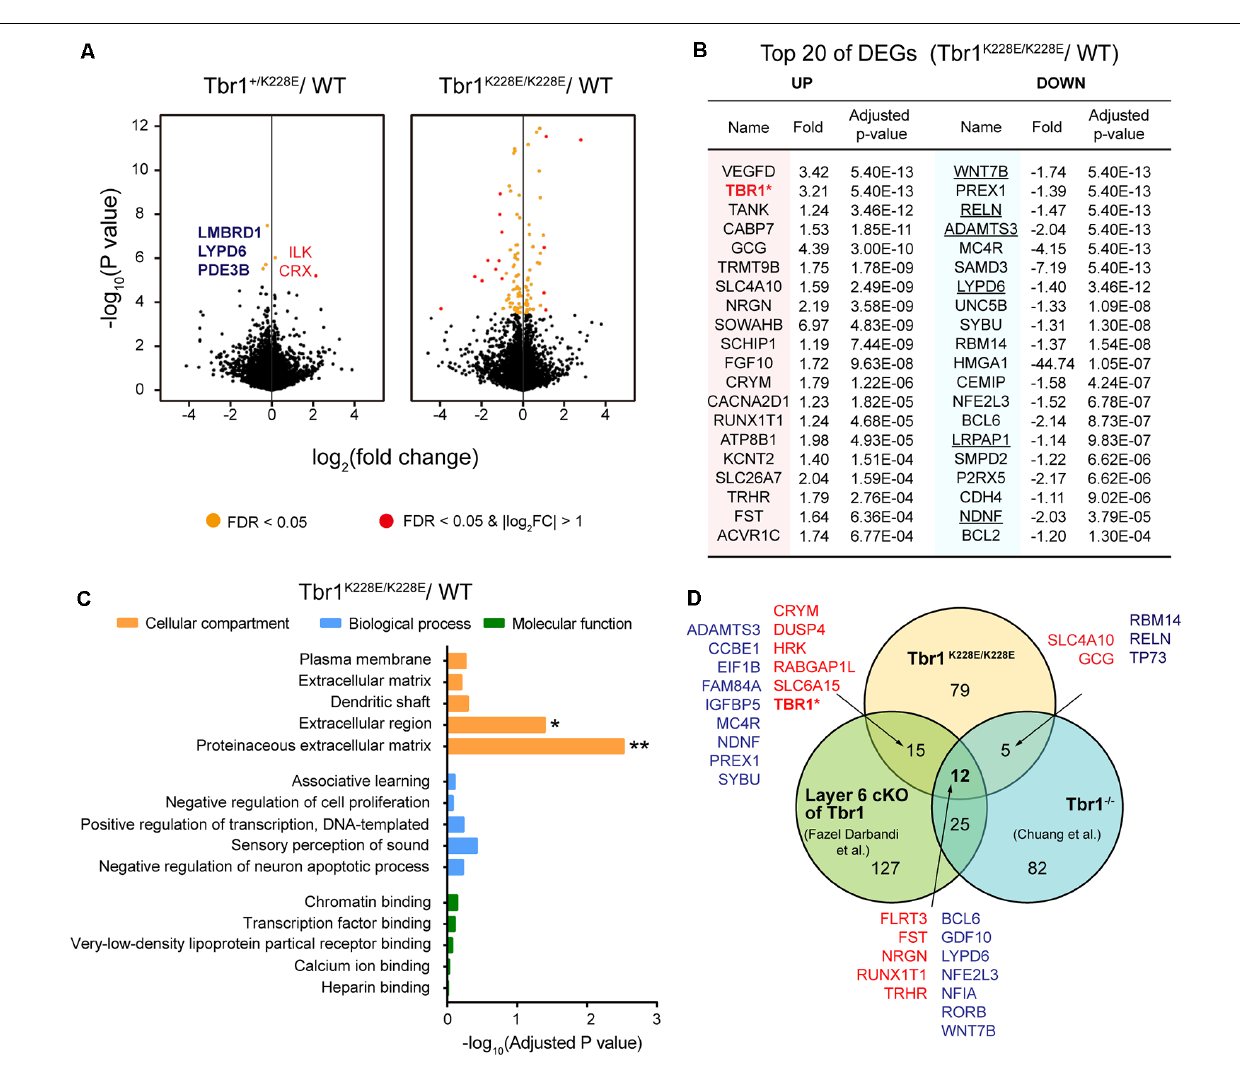
FIGURE 3 | Analysis of differentially expressed genes (DEGs) from Tbr1 + / K228E and Tbr1 K228E / K228E mice at E16.5. (A) Volcano plots showing DEGs from Tbr1 + / K228E and Tbr1 K228E / K228E brains (E16.5) relative to WT mouse brains. Names of the DEGs from Tbr1 + / K228E mice are indicated in the volcano plot, with the three DEGs shared in Tbr1 + / K228E and Tbr1 K228E / K228E mice indicated in bold; DEGs from Tbr1 K228E / K228E mice are indicated in the panel (B) . n = 5 mice for WT, Tbr1 + / K228E , and Tbr1 K228E / K228E , false discovery rate (FDR) < 0.05 (orange); FDR < 0.05 and |log 2 FC| > 1 (red). (B) List of the top 40 DEGs (20 up- and 20 downregulated) in the Tbr1 K228E / K228E brain (E16.5; forebrain). FC, fold change. The underlined gene names indicate DEGs associated with the extracellular matrix (ECM) or extracellular region—the two strongest gene ontology (GO) terms identified in DAVID analyses (see panel C ). (C) David GO analysis of the 111 DEGs from the Tbr1 K228E / K228E brain (E16.5; adjusted p -value < 0.05). Note that significant GO terms were found in the Cellular Component domain, but not in Molecular Function or Biological Process domains. *Adjusted p -value < 0.05; ∗∗ adjusted p -value < 0.01. (D) Venn diagram showing the overlap between the 111 DEGs from the Tbr1 K228E / K228E brain at E16.5 and the previously reported 124 DEGs from microarray analyses of the Tbr1 – / – forebrain at E16.5 (Chuang et al., 2015) and 178 DEGs from mice carrying a layer 6-specific homozygous Tbr1 deletion (Fazel Darbandi et al., 2018). Note that nearly all up- and downregulated DEGs (red and green, respectively) in the Tbr1 K228E / K228E brain showed up- and downregulation similar to those of the previous results, with the exception of Tbr1 , which was upregulated (not downregulated) in the present study. There were no significant associations between the three different groups by Fisher analysis (see Supplementary Table S2 for